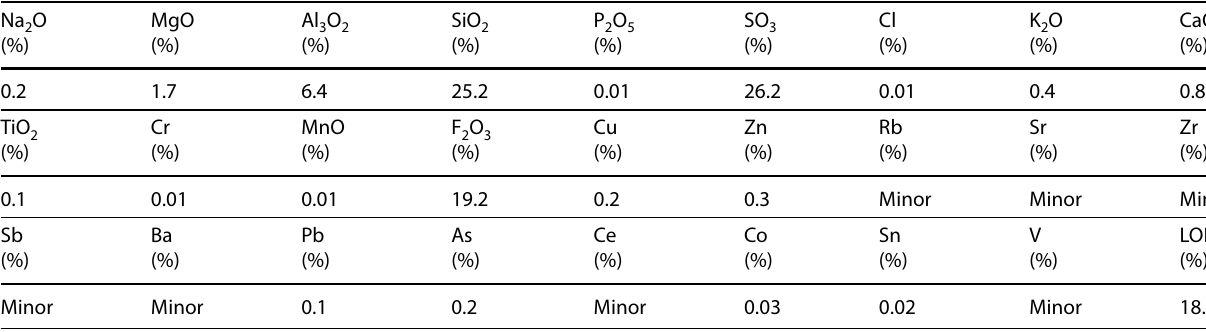
Table 1 X-ray fluorescence. Major elements (%)